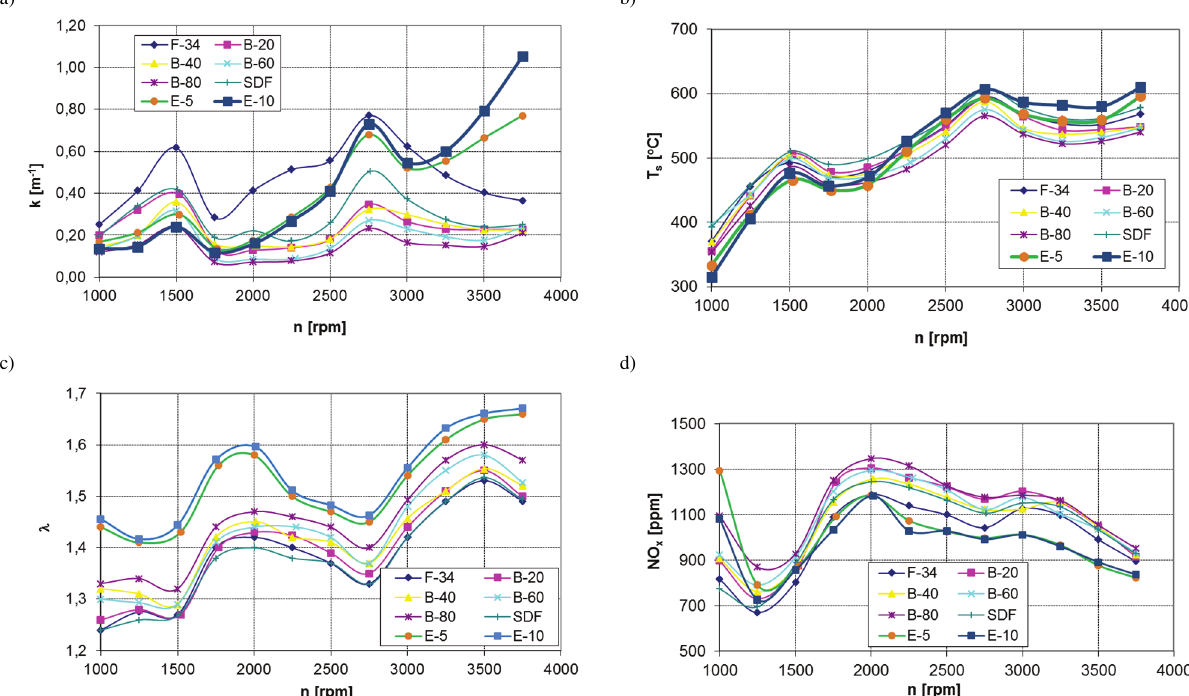
Fig. 3. External characteristic of the engine: a) extinction coefficient of absorbed radiation , b) temperature of exhaust gases, c) air/fuel ratio coefficient, d) concentration of nitrogen oxides in